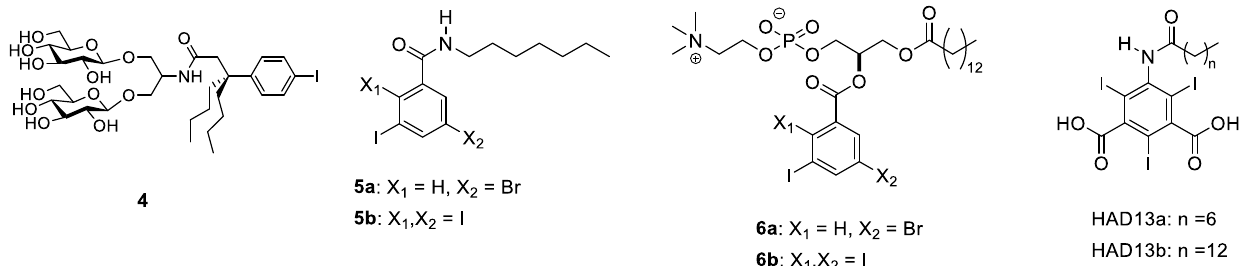
Figure 3. Lipophilic compounds and detergents bearing multiple halogen substitutions that can be used to solve the phas- ing problem for membrane protein structures. problem for membrane protein